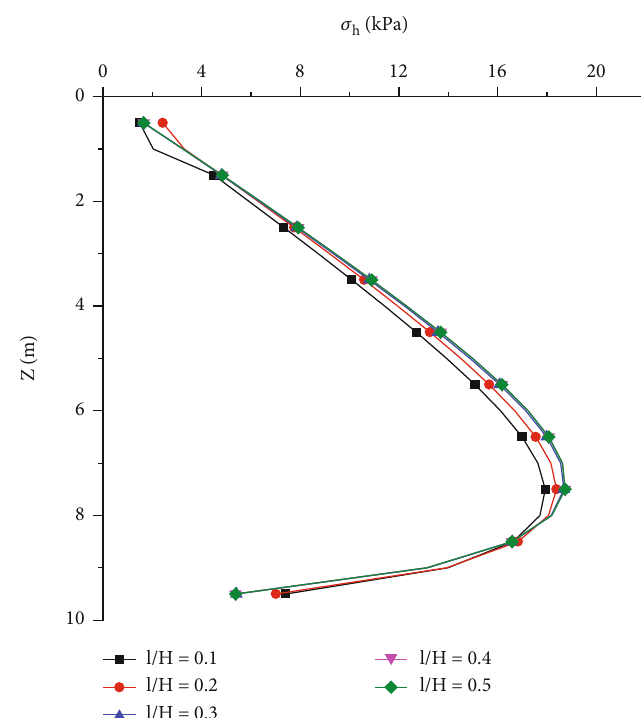
Figure 8: Distribution of active earth pressure under di ff erent l / H ( α = 40